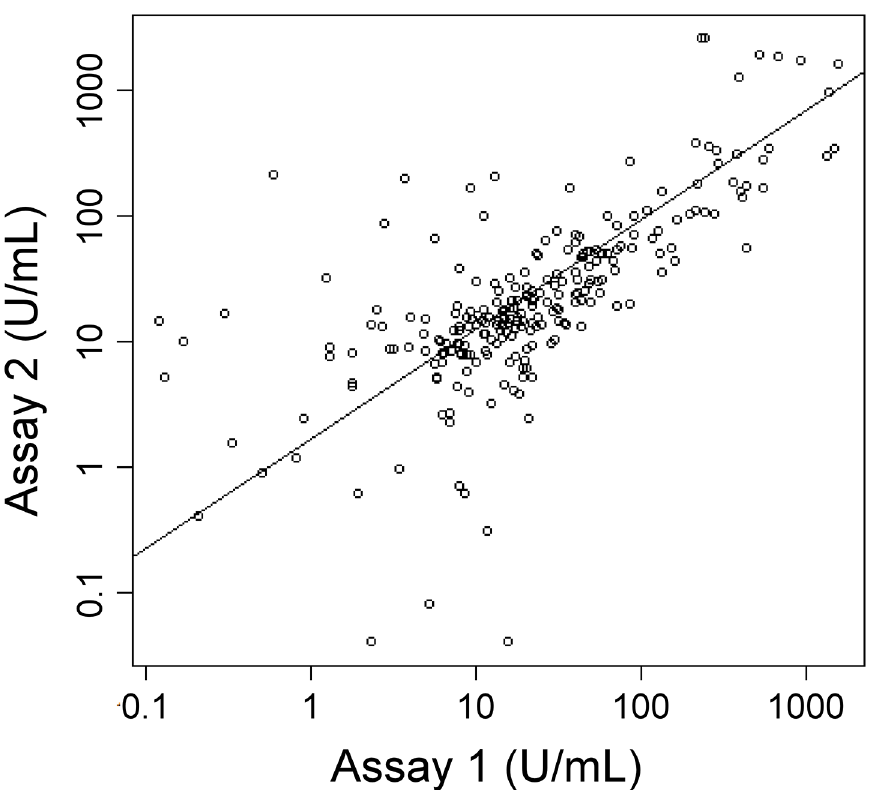
Fig 2. Correlation between Assay 1 and Assay 2. The log-transformed CA 19 – 9 values of all subjects from Assay 1 and Assay 2 were plotted with respect to each other. Each circle indicates an individual patient sample. The trendline is the linear-least squares best fit, and the Spearman ’ s rank correlation coefficient is 0.74. doi:10.1371/journal.pone.0139049.g002 Both antibodies bound the canonical CA 19 – 9 antigen — sialyl Lewis A — but with differ- ences (Fig 3 and Fig 4). The antibody from Assay 2 (9L426) bound more strongly than the Assay 1 antibody to dimeric sLeA-LeA, as evidenced by the better signal at the low concentra- tion of 0.2 μ g/mL, but it showed no binding to the sialic acid variant Neu5Gc. It also bound to sialyl Lewis C (non-fucosylated sialyl Lewis A) at the relatively high concentration of 20 μ g/ mL. In contrast, the Assay 1 antibody (only the detection antibody was available from the